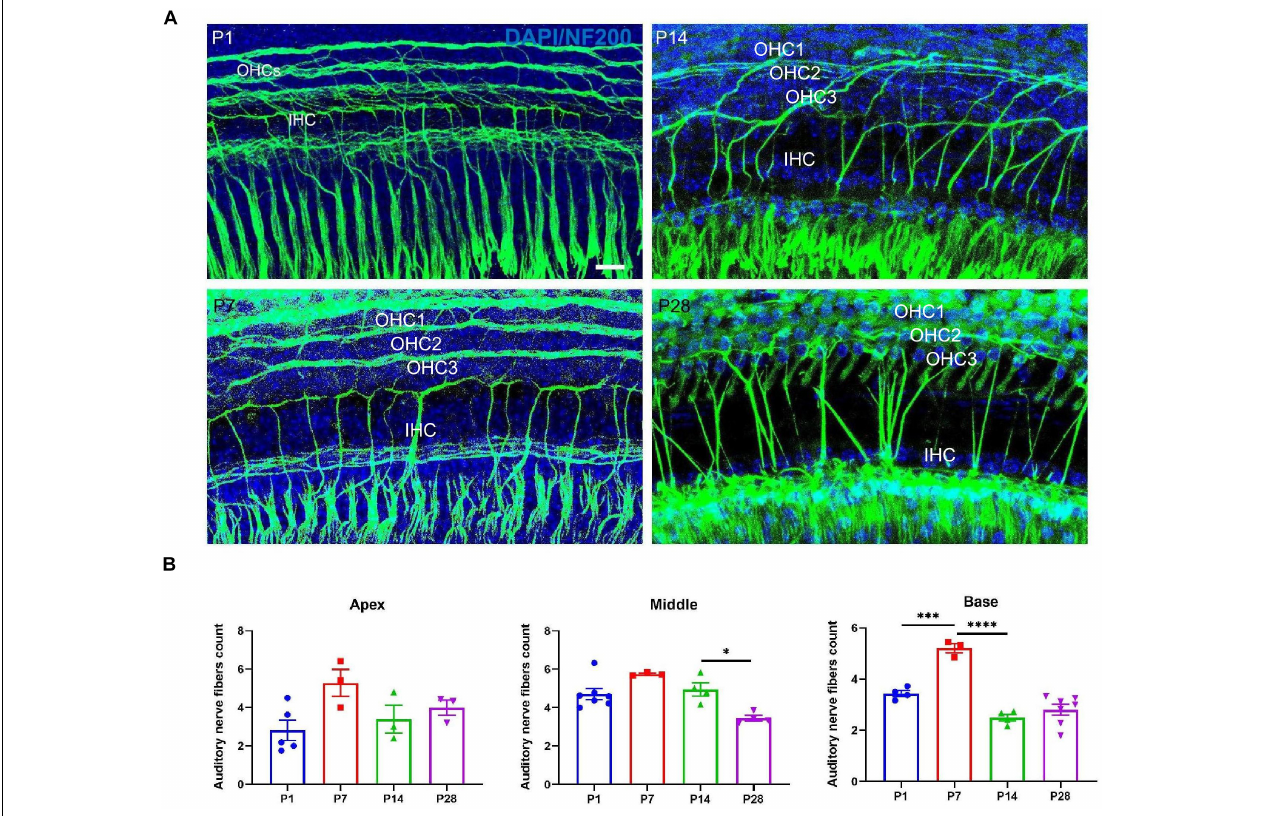
FIGURE 7 | Examination of the number of auditory nerve fibers. (A) Auditory nerve fibers were traced using anti-NF200 (green), and a massive number of auditory nerve fibers were seen at P1 and P7; a reduced number of auditory nerve fibers appeared at P14 and P28. Scale bar = 5 µ m. (B) Compared with P1 and P7, quantitative analysis showed a significant loss of auditory nerve fibers at P14 and P28 in the middle and basal turns (* p < 0.05) and no significant difference at the apical turn ( p > 0.05), suggesting that postsynaptic auditory nerve fibers also undergo significant pruning in the developing cochlea (*** p < 0 . 001; **** p < 0 . 0001). NF200, neurofilament